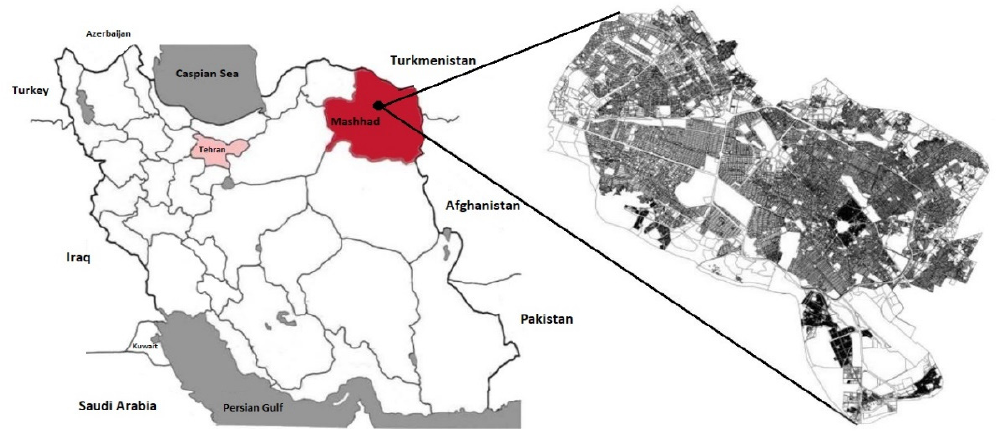
Figure 1. Location of the city of Mashhad in Razavi Khorasan Province, Iran.